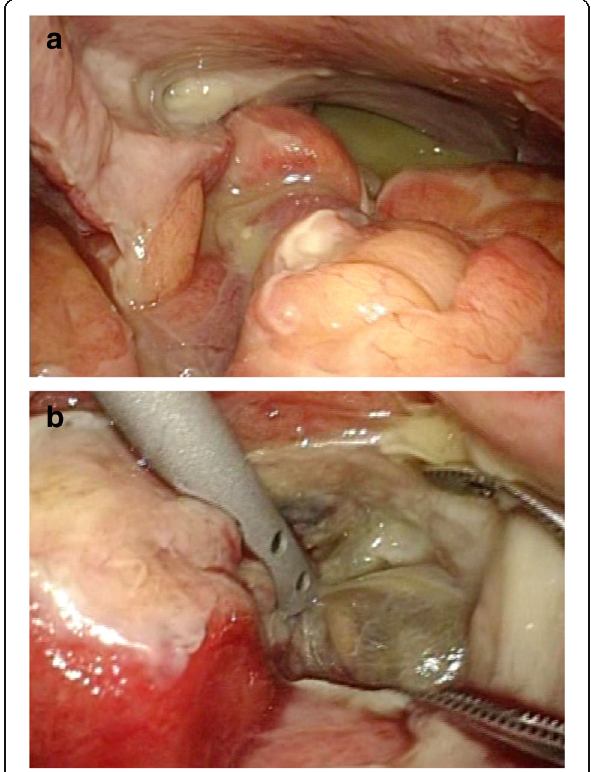
Fig. 4 Initial operative findings. a Purulence in the rectovesical pouch. b Abscess cavity of the mesentery of the sigmoid colon